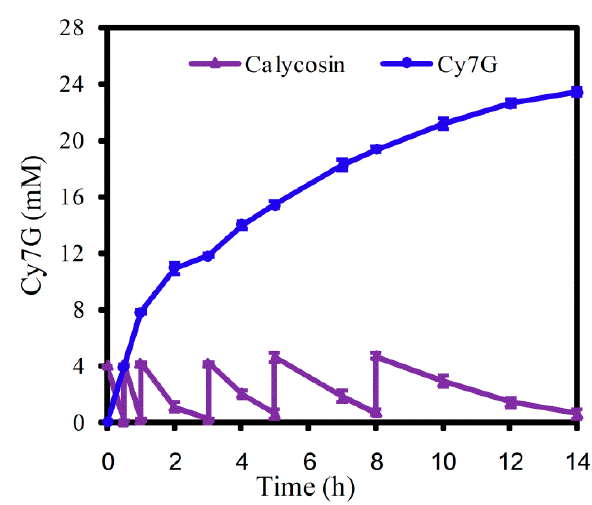
Figure 4. Fed-batch synthesis of Cy7G by UGT88E18–SuSy cascade reaction. Stepwise addition of 100 µ L of fresh calycosin, stocked in dimethyl sulfoxide (DMSO, 400 mM), to reactants at 0.5, 1, 3, 5, and 8 h.